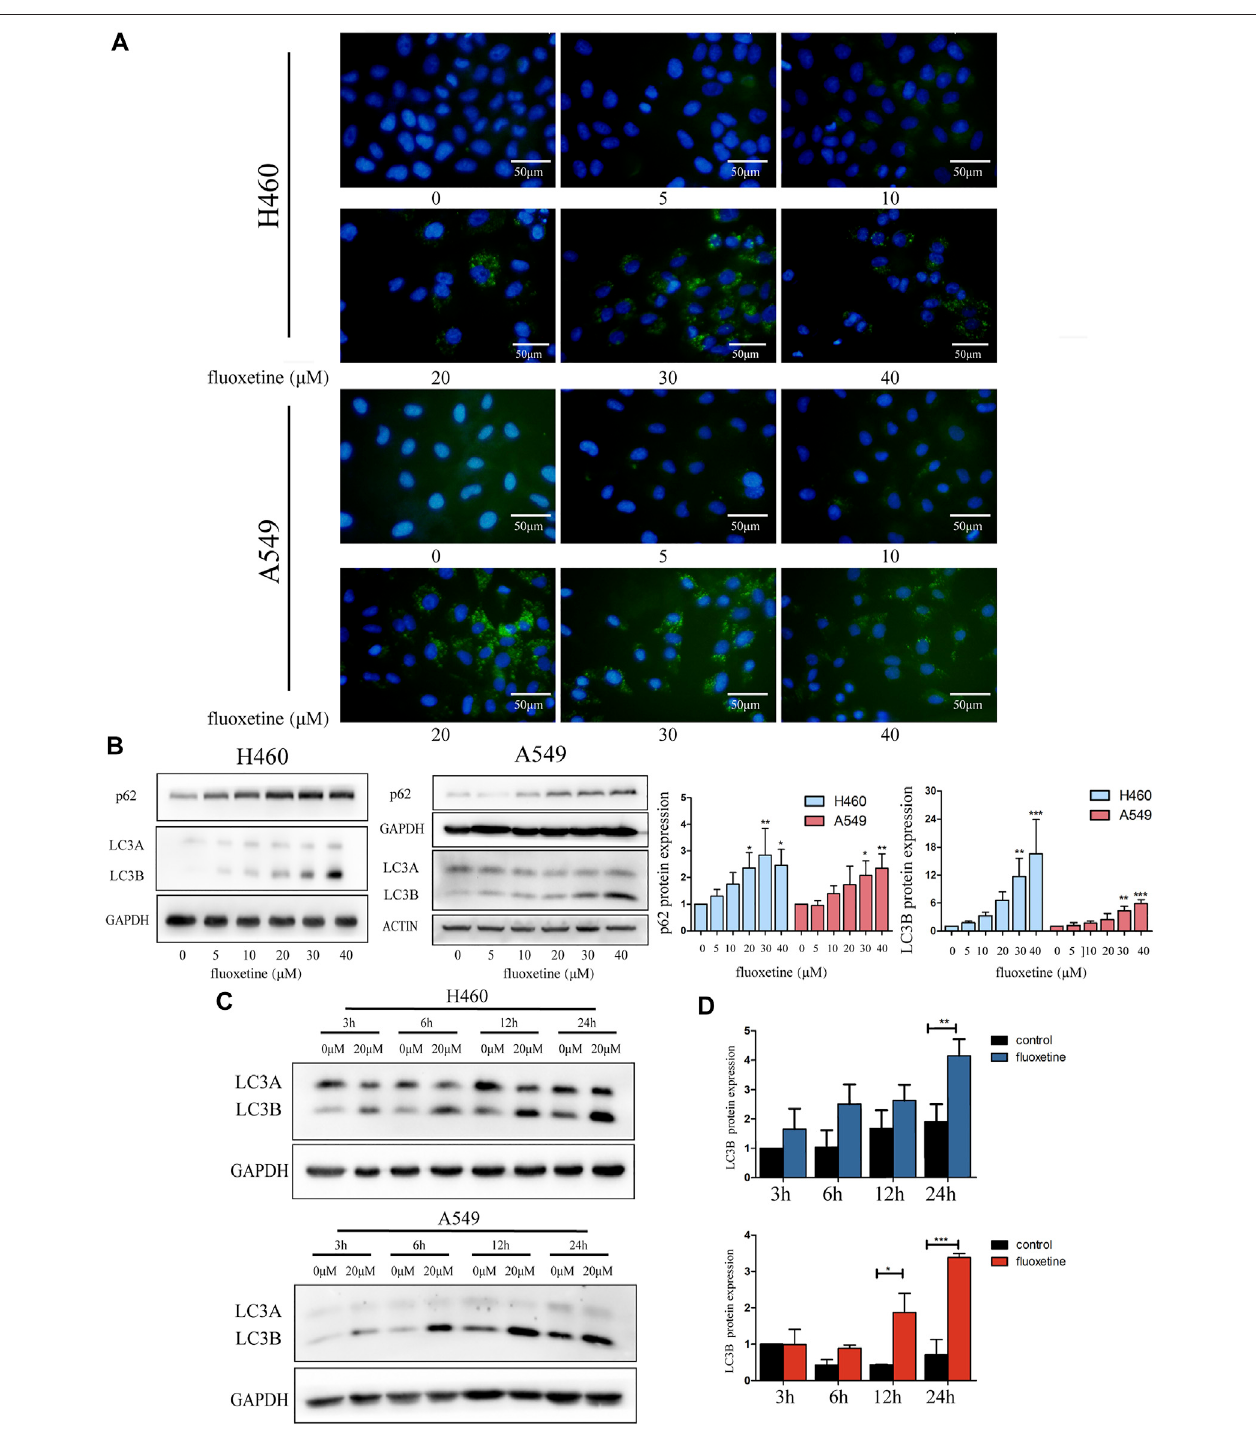
FIGURE 3 | Fluoxetine induced autophagy in a dose and time-dependent way (A) Cells were treated with fl uoxetine (0 – 40 μ M) for 24 h. Immuno fl uorescence of LC3 (green) and nuclear (blue) were used to observe autophagy. Scale bars were 50 μ m. (B) The Western blot result of p62 and LC3. Cells were treated with fl uoxetine (0 – 40 μ M)for24 h.Theimageswerecollectedfromdifferentpartsofthesamegel. (C) WesternblotresultofLC3incontroland fl uoxetinegroups.Cellsweretreatedwith fl uoxetine(20 μ M)for3,6,12,and24 h.Theimageswerecollectedfromdifferentpartsofthesamegel. (D) Quantitativeanalysisofopticalbanddensitometry.Data are presented as mean ± SD; * p < 0.05, ** p < 0.01, *** p < 0.001.